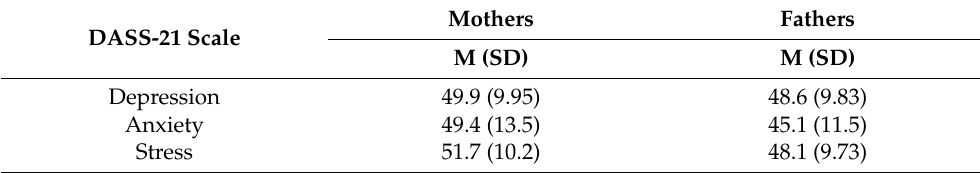
Table 3. Mean (M) and Standard Deviation (SD) values in the DASS-21 scales of parents at